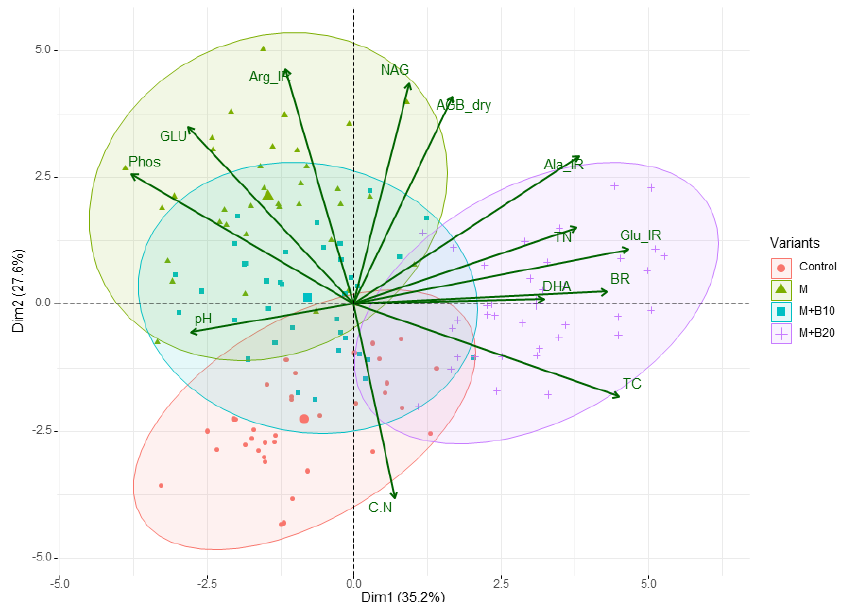
Figure 3. The effects of different amendments on: ( a ) basal respiration; ( b ) D -glucose-induced respiration; ( c ) L -alanin induced respiration; and ( d ) L -arginine-induced respiration. Different lowercase letters represent statistical difference at p = 0.05, ( n = 3).